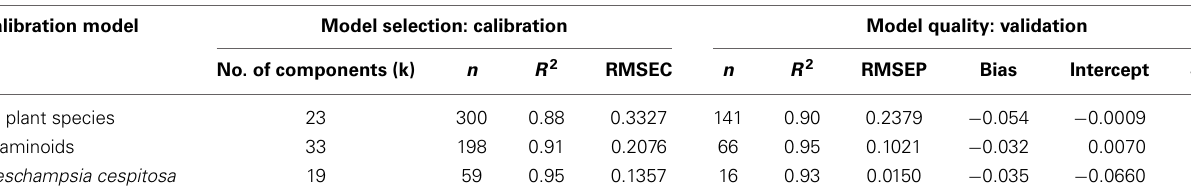
Table 2 | Calibration and validation statistics ( R 2 : coefficient of determination; RMSEC: root mean square error of calibration; RMSEP: root mean square error of prediction) of the Partial Least Squares regression models on NIR spectra for the analysis of plant Si concentration in three separate models.